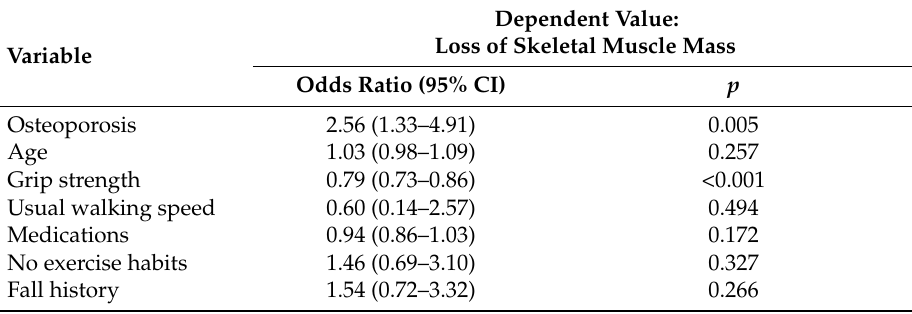
Table 2. Odds ratios for loss of skeletal muscle mass associated with osteoporosis.